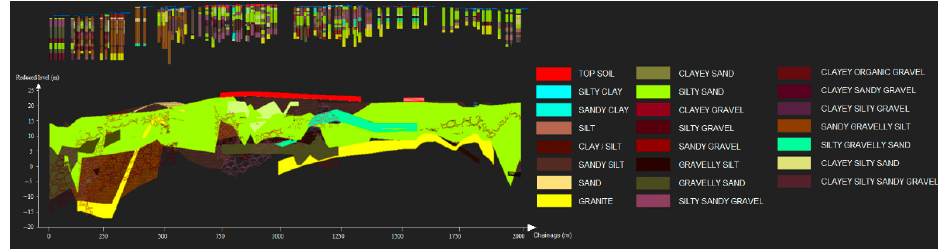
Figure 5. Cross-sectional profile for Case Study 1 based on detailed soil investigation data.